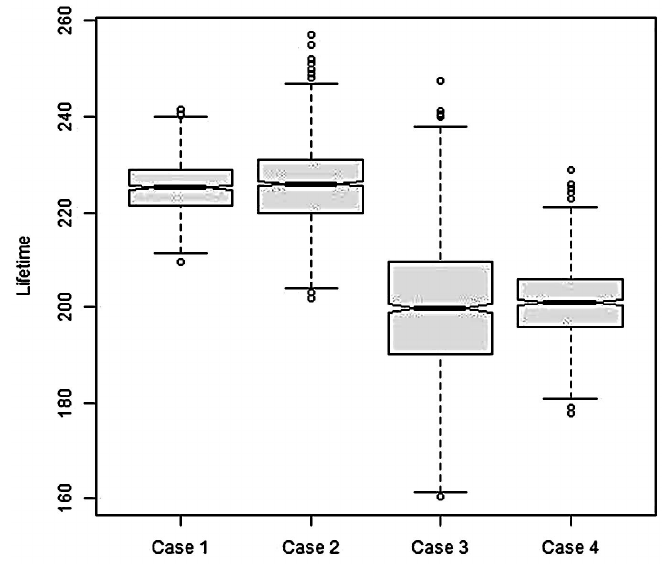
Figure 5. Boxplot diagram for sensor lifetime.